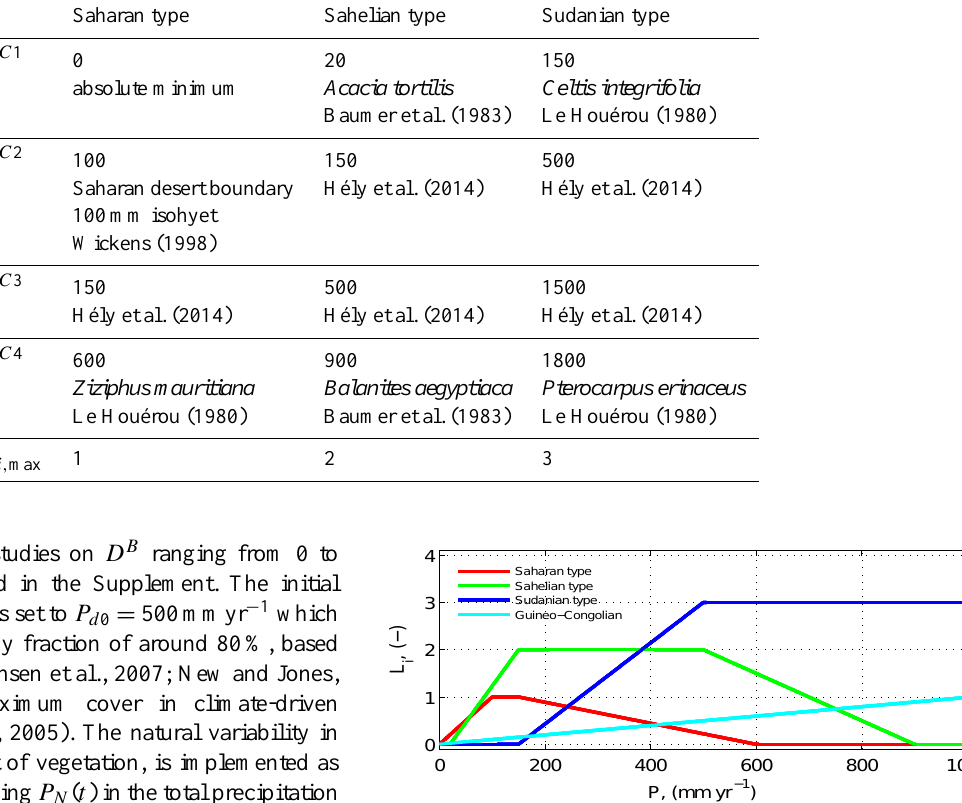
Table 1. Precipitation thresholds P C 1